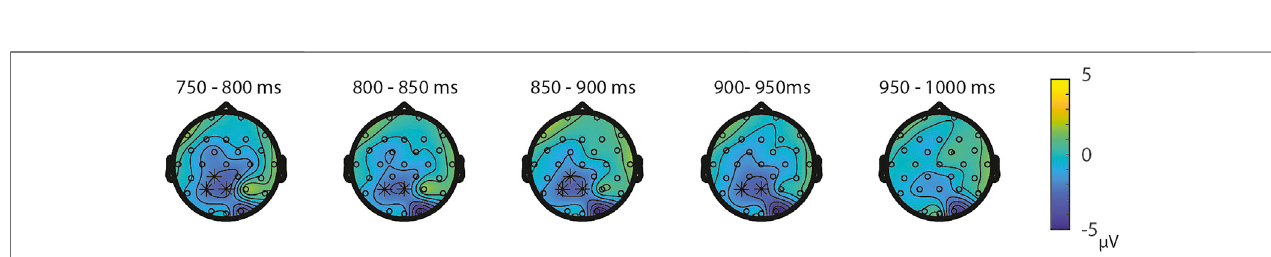
FIGURE 3 | Topoplots of the differences between the ratio ’ s in the NsNs-task per time window with asterisks representing the signi fi cant differences between the ratios based on α (cid:1) 0.05.